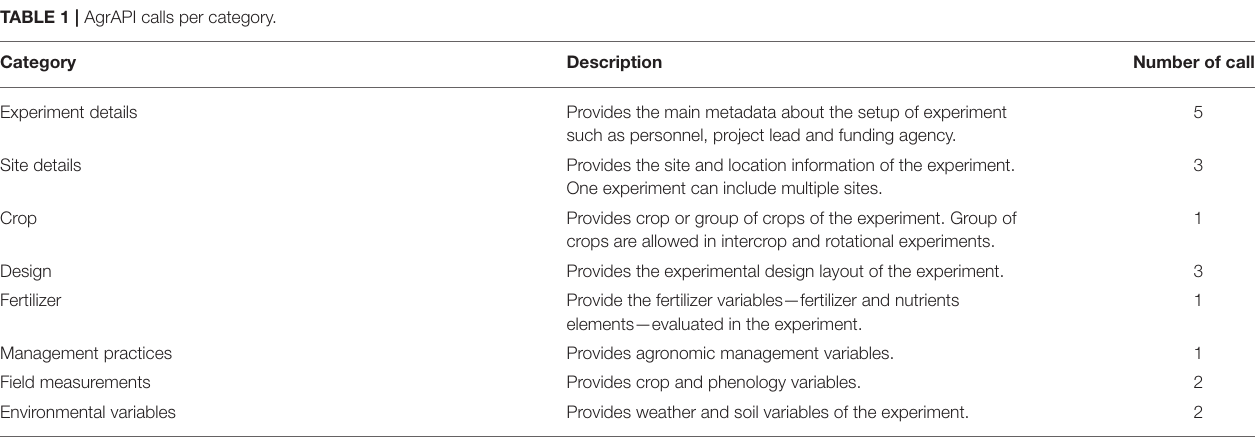
TABLE 1 | AgrAPI calls per